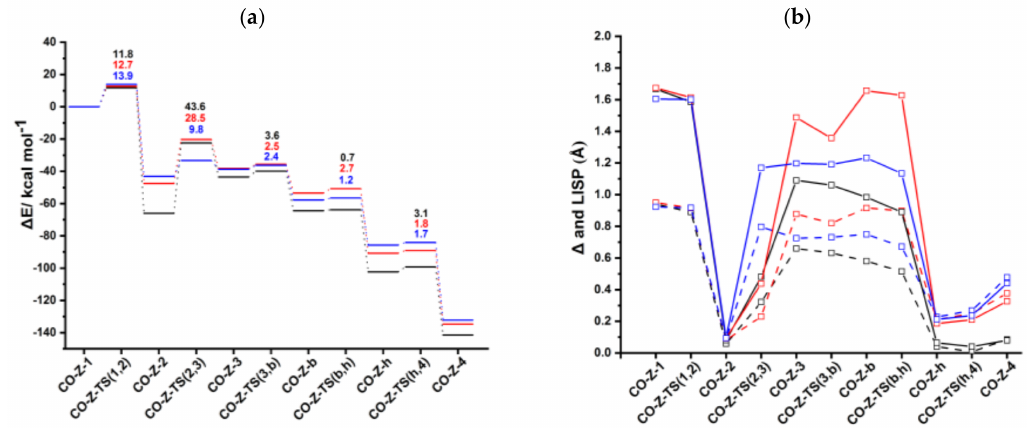
Figure 6. ( a ) Energy profiles of acetylene [2 + 2 + 2] cycloaddition to benzene catalyzed by CpRh(CO) (black), IndRh(CO) (red), and anti-IndRh(CO) (blue) (Scheme 3b, Path II). ( b ) Profiles of the slippage parameters ∆ (dashed line) and LISP (solid line) along the acetylene [2 + 2 + 2] cycloaddition cycles catalyzed by CpRh(CO) (black), IndRh(CO) (red), and anti-IndRh(CO) (blue) (Scheme 3b, Path II). Level of theory: ZORA-BLYP /